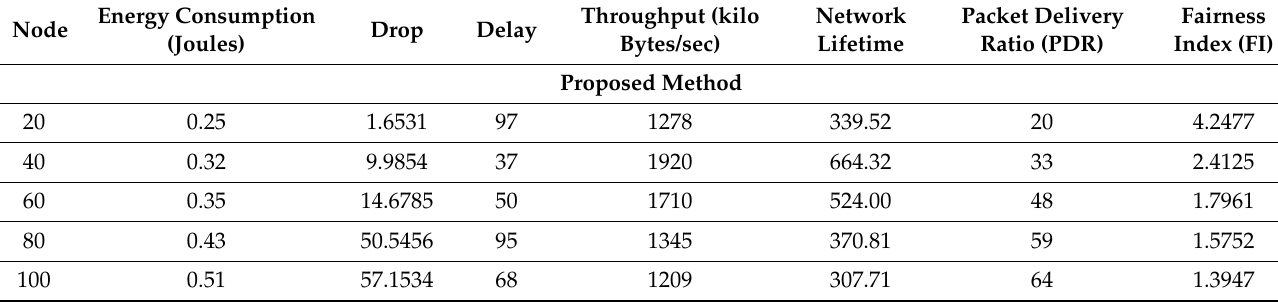
Table 3. Performance of proposed